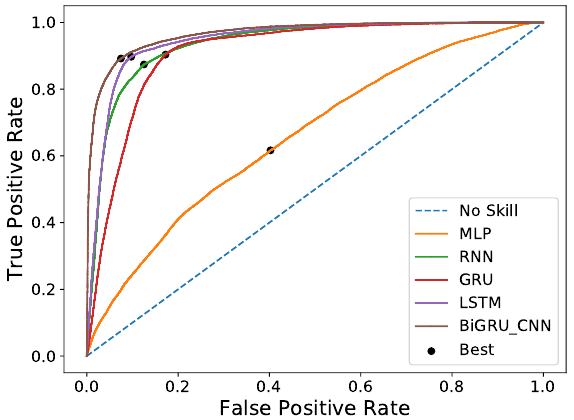
Figure 10. ROC curve of all neural